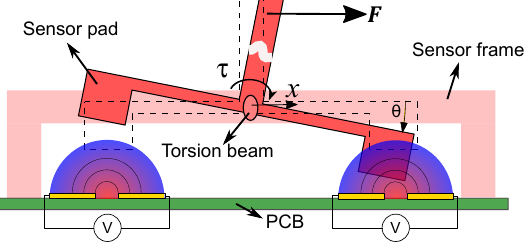
Figure 3. Coplanar capacitive sensing using interdigitated fingers with dielectric loading (Delamare et al., 2016).